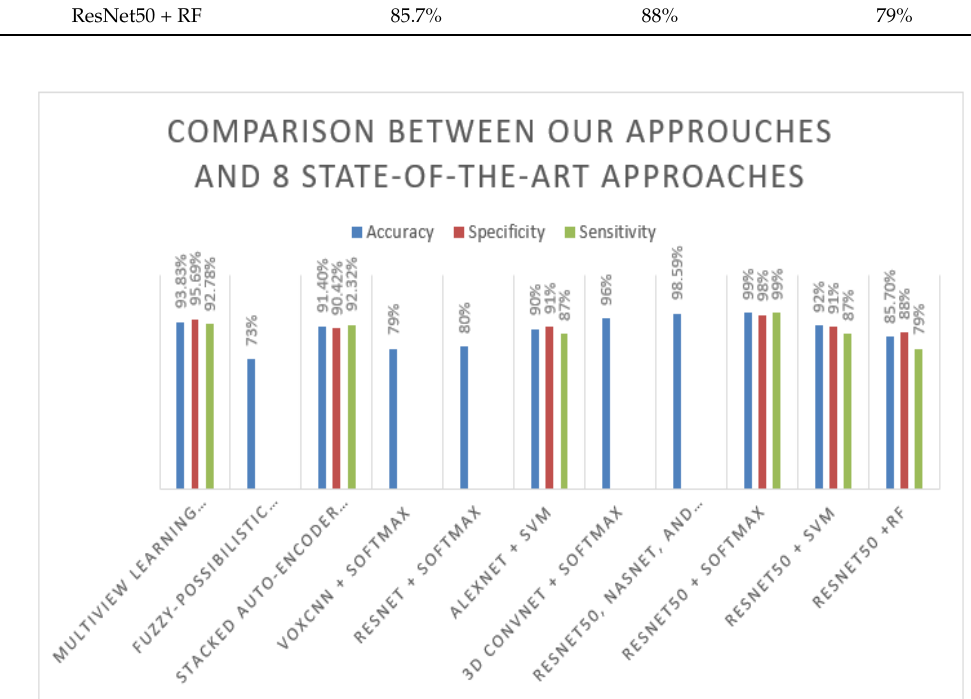
Figure 7. Comparison between our approaches and eight state-of-the-art approaches. Table 6. Comparison of our test performance with eight existing state-of-the-art methods. Models